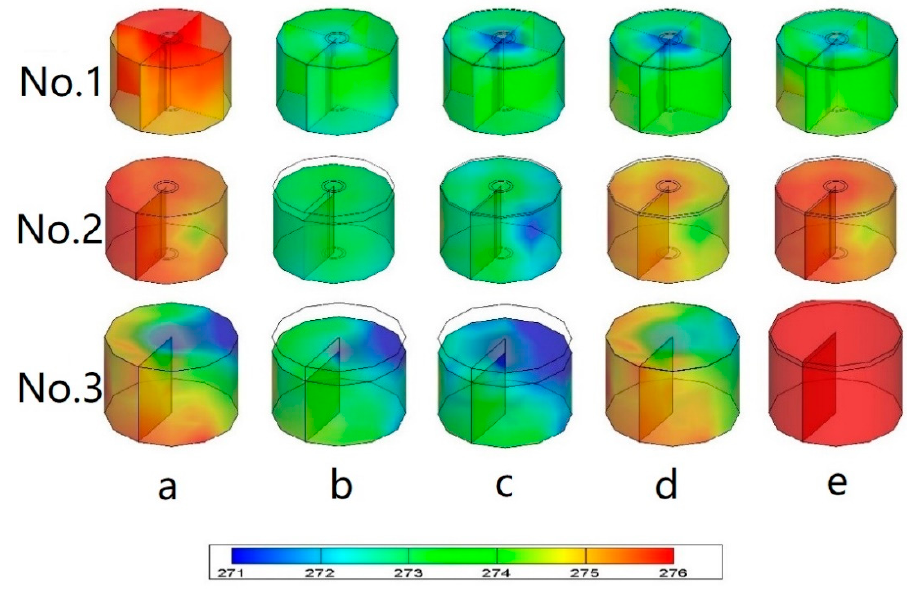
Figure 5. Temperature spatial distribution and subsidence over time in experiments.